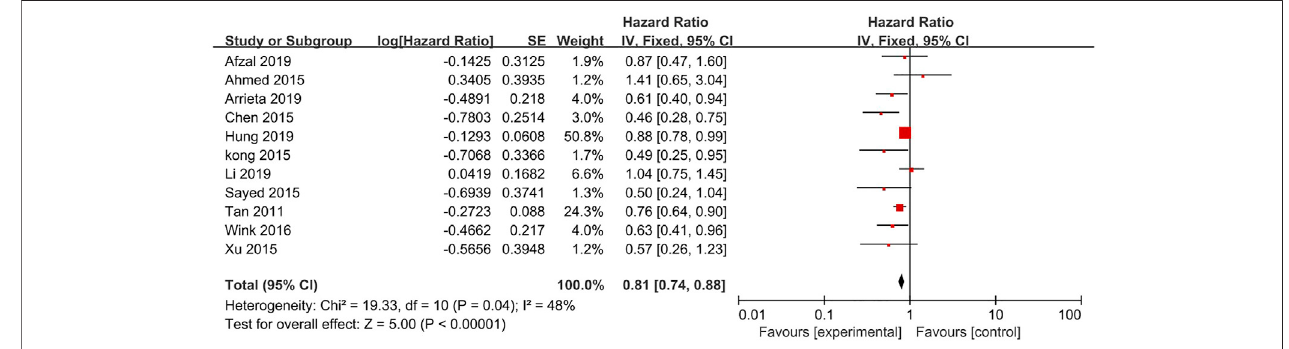
FIGURE 3 | Forest plot for the meta-analysis on progression-free